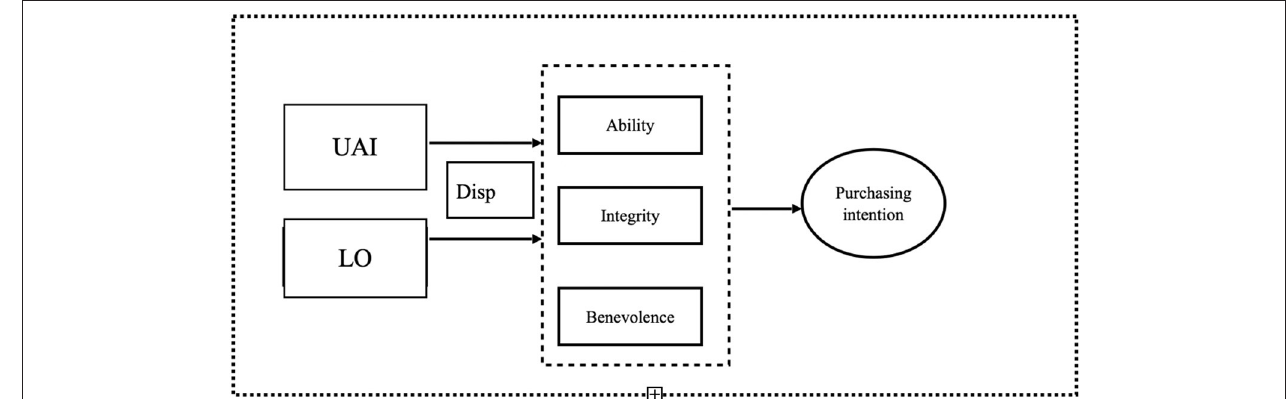
FIGURE 1 | Research model.